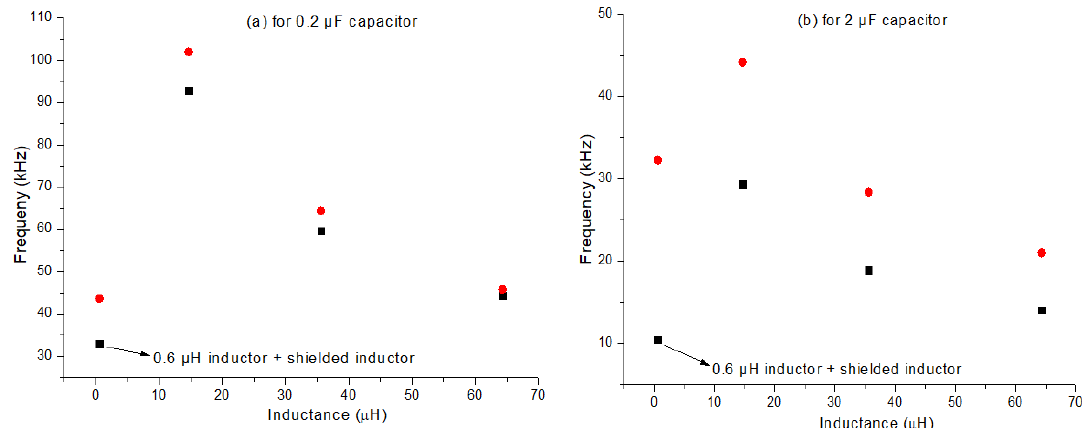
Figure 3. ( a ) Resonance frequency of the RLC circuit using 0.2 µ F capacitors. ( b ) Shows the Resonance frequency of the RLC circuit using 2 µ F capacitors. In both the figure the red dots represent the experimentally derived and the black dots represent the theoretically calculated resonance frequencies.